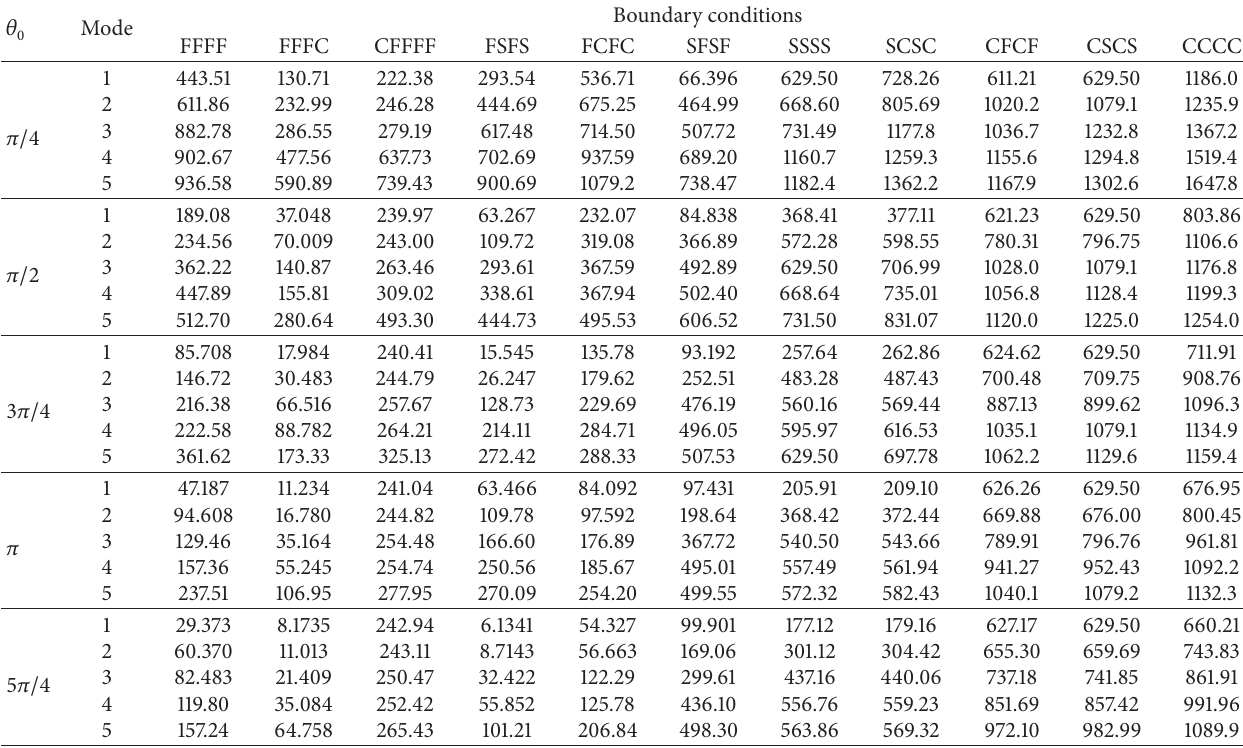
Table 16: The first five frequencies (Hz) of an open orthotropic spherical shell with various boundary conditions and included angles ( 𝜙 0 = = 𝜋/2 , 𝑅 = 1 m, and ℎ/𝑅 = 0 . 3). 𝜋/4 , 𝜙 1